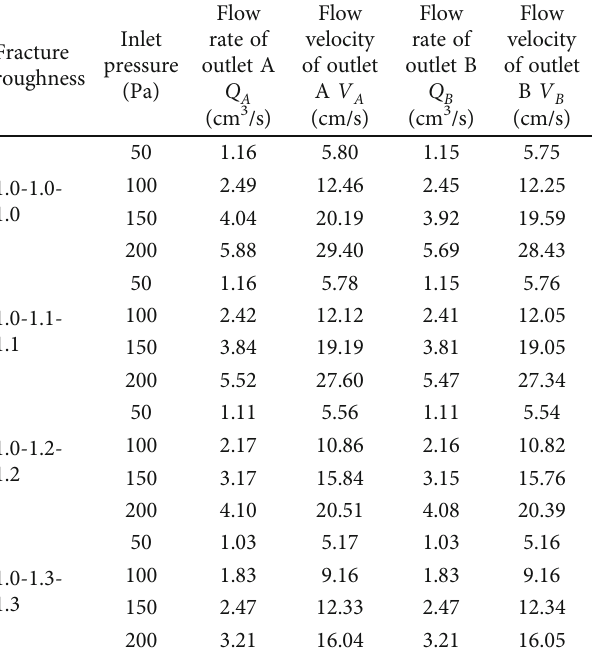
Table 2: Fluid seepage results under di ff erent inlet pressures = D ( D ). B C Fracture